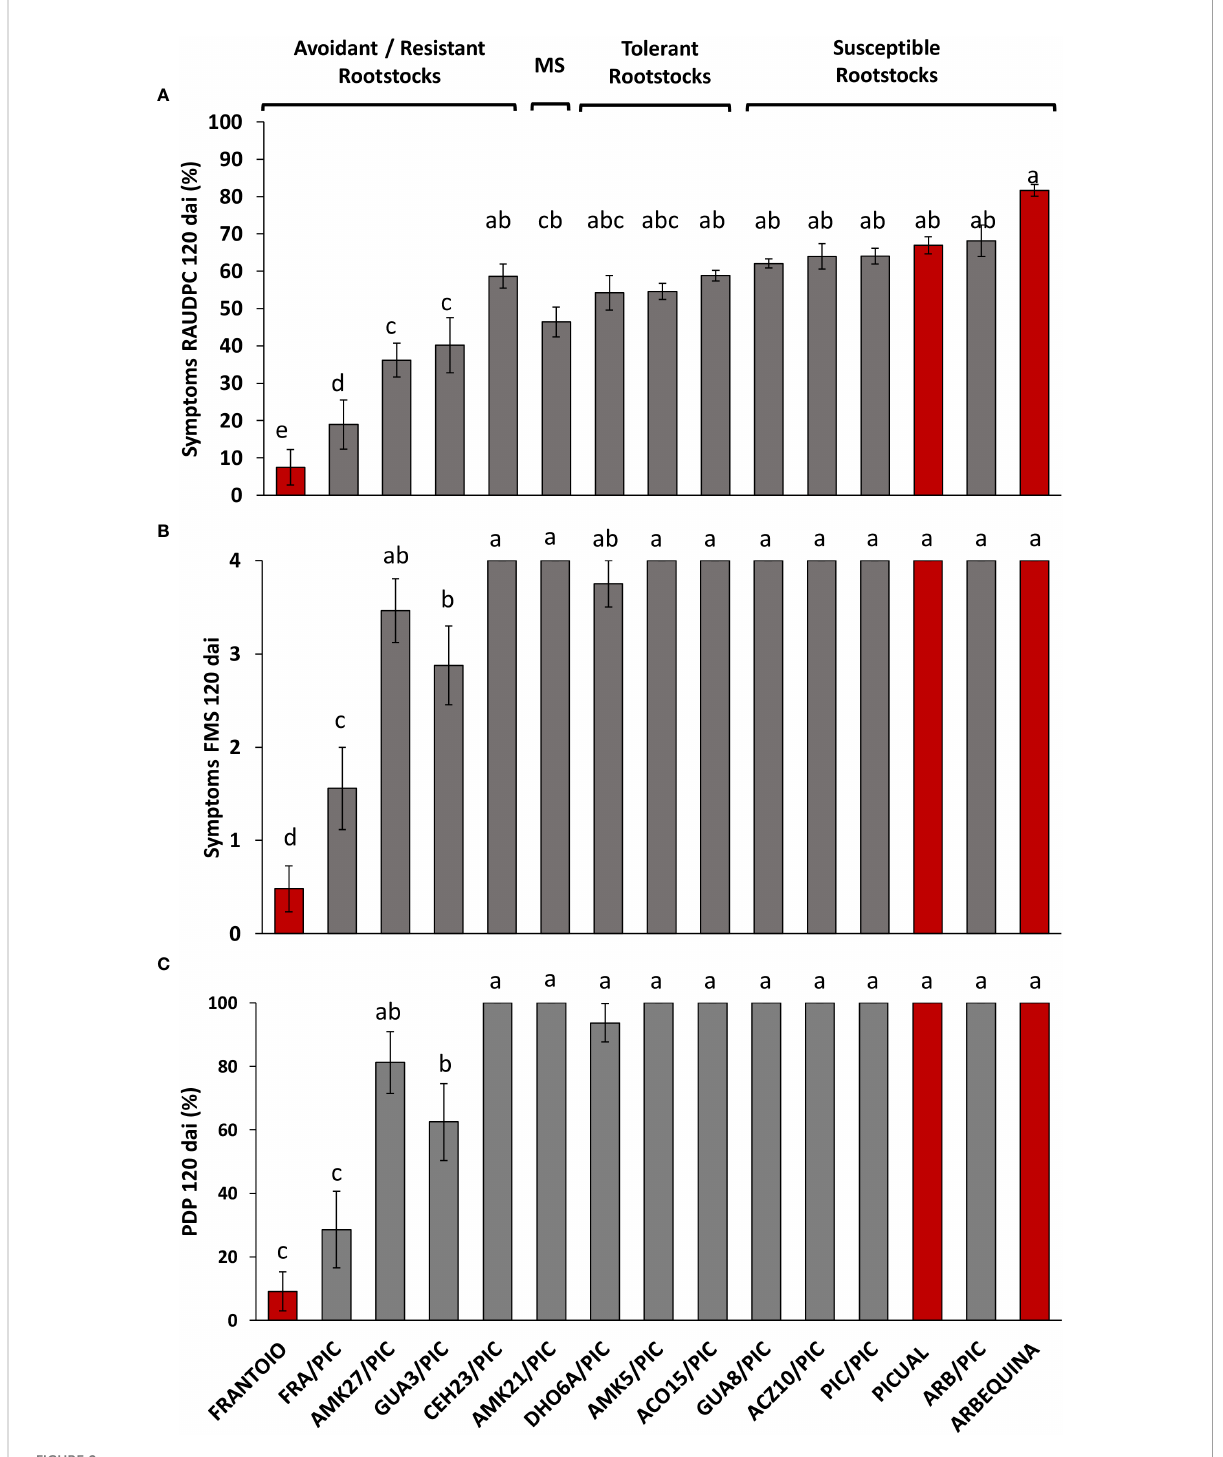
FIGURE 2 Relative Area Under the Disease Progress Curve (RAUDPC) (A) , Final Mean Severity (FMS) (B) and Percentage of Dead Plants (PDP) (C) of cultivar ‘ Picual ’ grafted onto different olive rootstocks inoculated with the Verticillium dahliae defoliating isolate VD117, at 120 days after inoculation (dai). Red bars correspond to non-grafted reference cultivars: the resistant ‘ Frantoio ’ , the moderately susceptible ‘ Arbequina ’ , and the extremely susceptible ‘ Picual ’ , according to the levels of resistance described by Lo ́ pez-Escudero et al. (2007). Results are the mean of 16 plants and error bars correspond to the standard error. Different letters above bars indicate signi fi cant differences according to LSD test